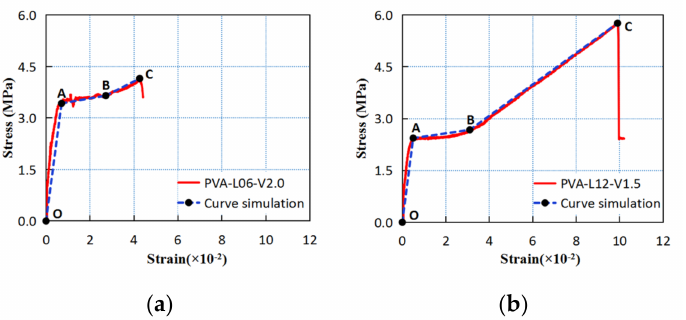
Tensile stress-strain curves of PVA fiber-reinforced coral cement-based compos- ites specimens.